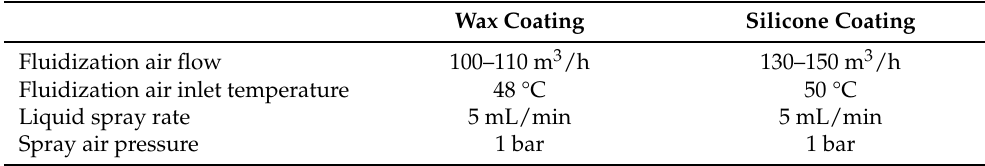
Figure 2. Scheme of the fluidzed bed setup used for coating experiments. Table 1. Process parameters during